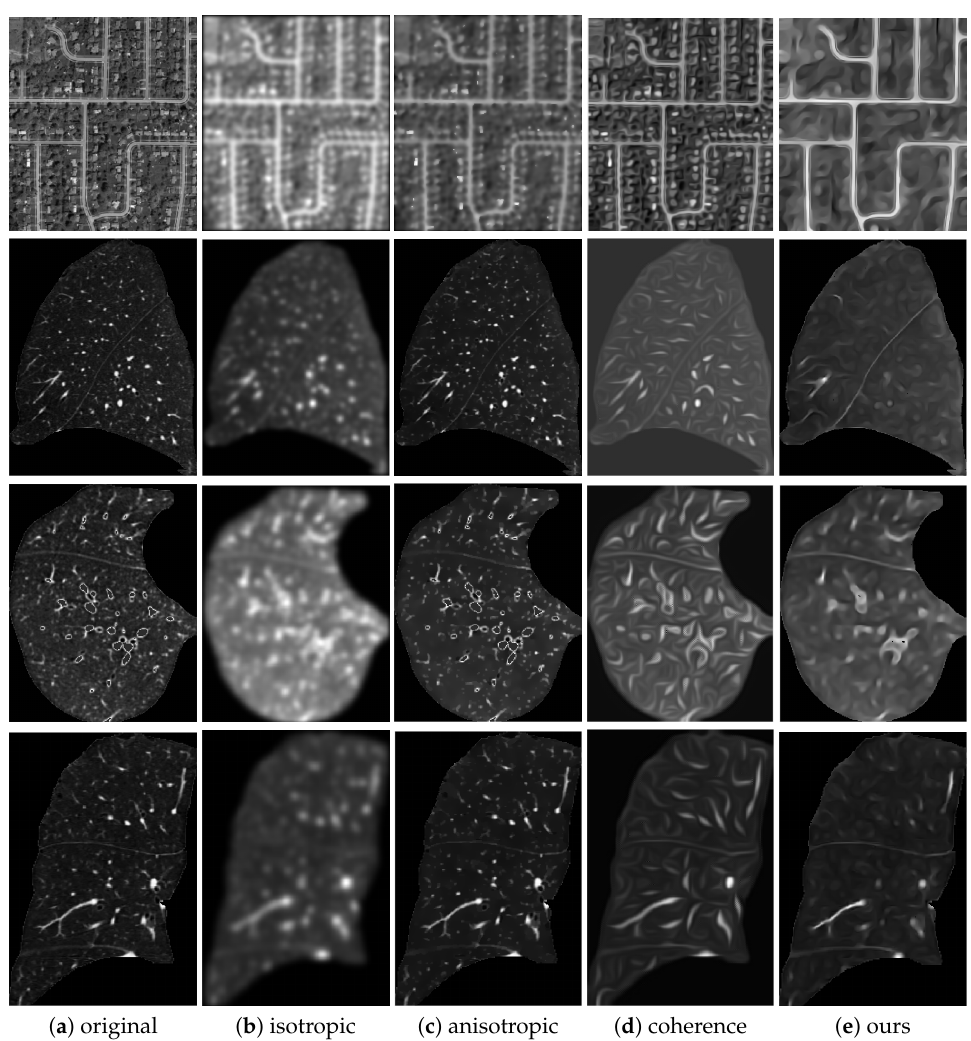
Figure 3. Qualitative comparison of image representations for ( a ) the original image and the diffused images obtained using diffusion processes based on ( b ) isotropic diffusion using a Gaussian kernel, ( c ) anisotropic diffusion via the method proposed by Perona–Malik [25], ( d ) coherence-enhancing diffusion via the method proposed by Weickert [44], and ( e ) our proposed algorithm using recursive anisotropic diffusion. the diffusion results are shown for the aerial, lung CT (sagittal), lung CT (axial), and lung CT (coronal) images from top to